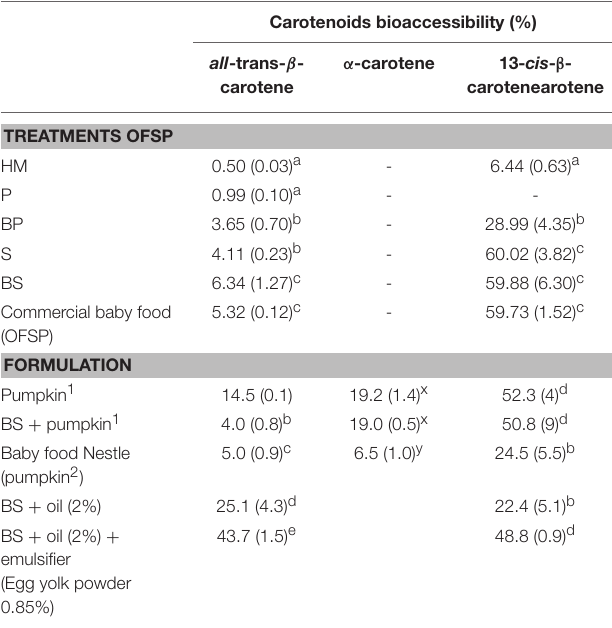
TABLE 2 | Carotenoid bioaccessibility in different thermal treatments and formulation of OFSP puree. Carotenoids bioaccessibility (%) all -trans- β - α carotene